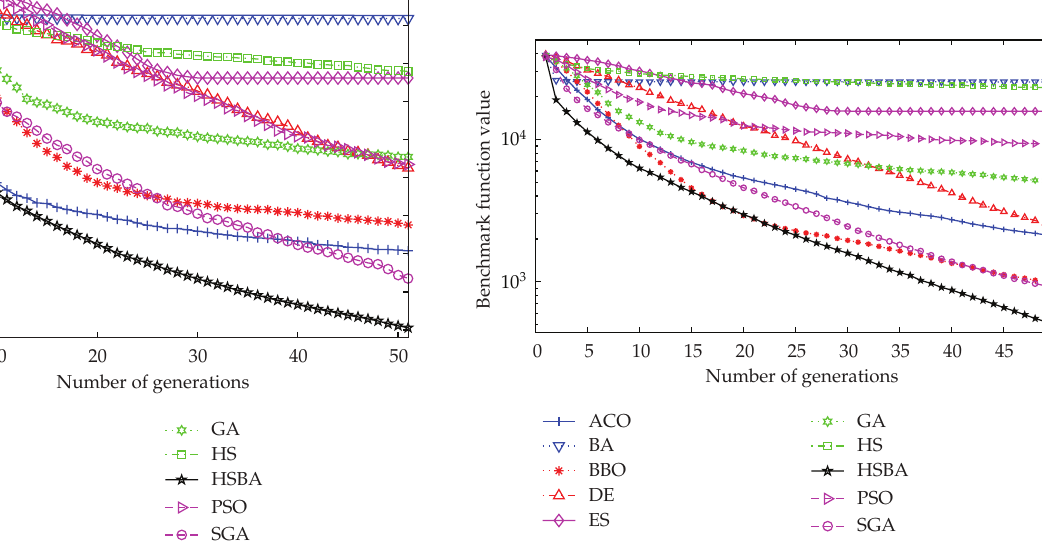
Figure 12: Comparison of the performance of the different methods for the F12 Schwefel 2.21 function.